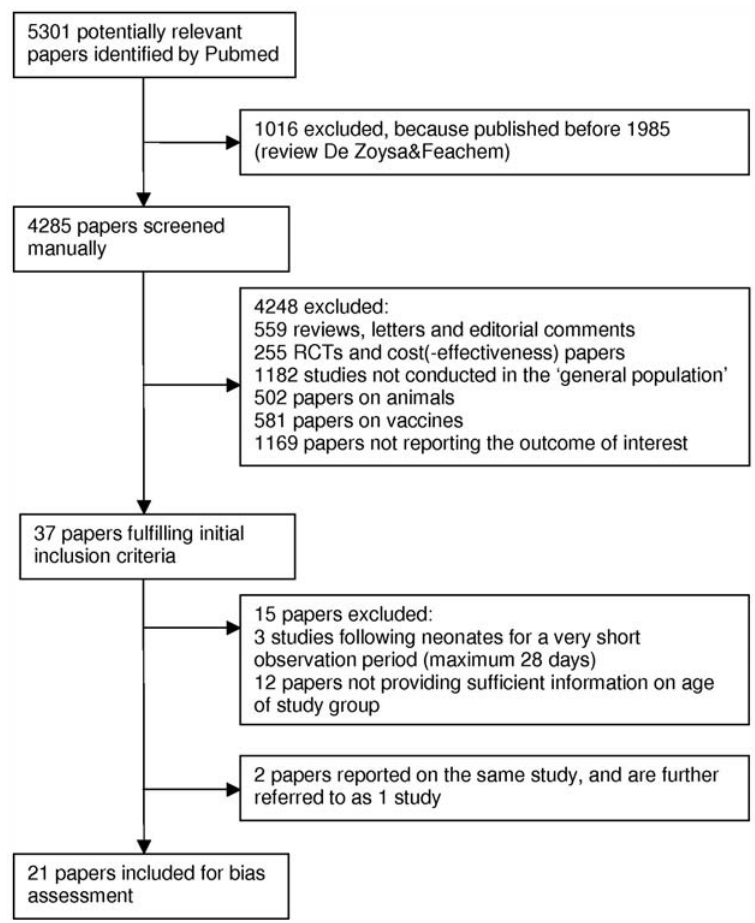
Figure 1. Flow diagram of the studies reviewed.